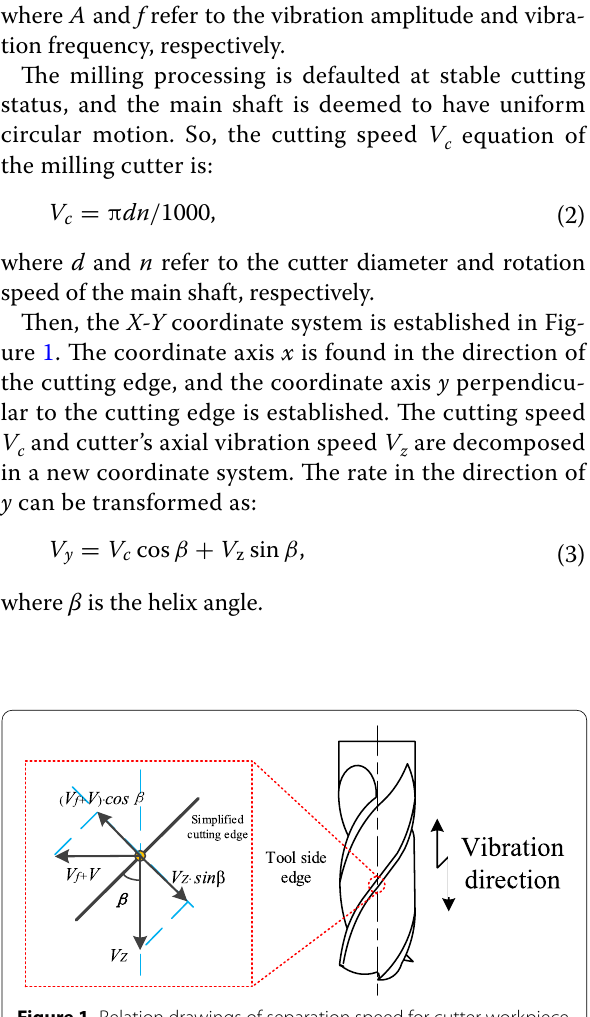
Figure 1 Relation drawings of separation speed for cutter